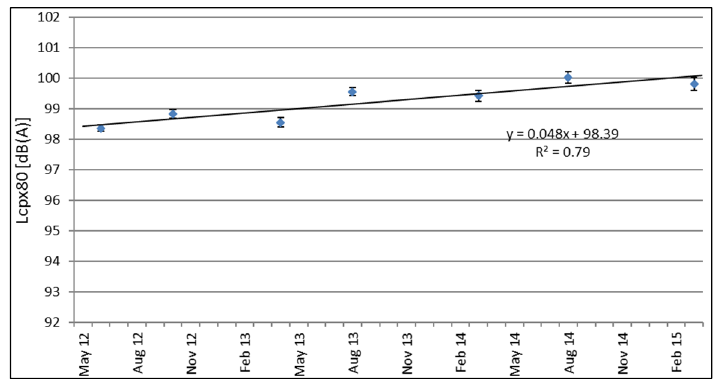
Figure 11. Increase over time based on CPX results (H1 tire) for Test Section 1 (SMA ‐ 10).